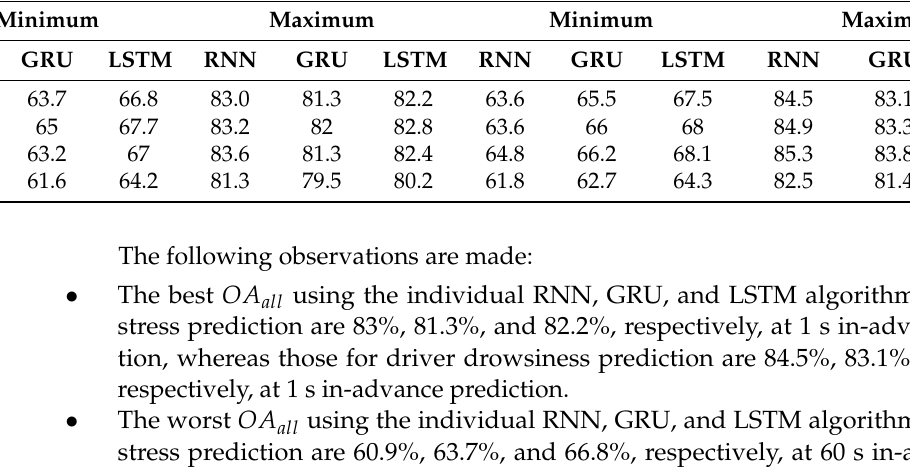
driver drowsiness prediction models using individual RNN, GRU, and LSTM algorithms.